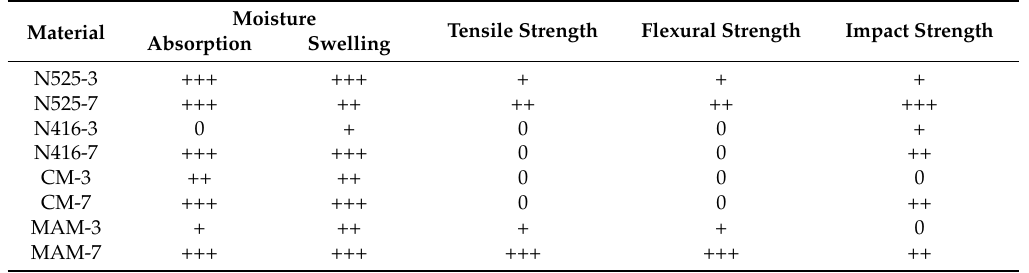
Table 5. Summary of different performances. Change in performance below 10% is marked with 0,